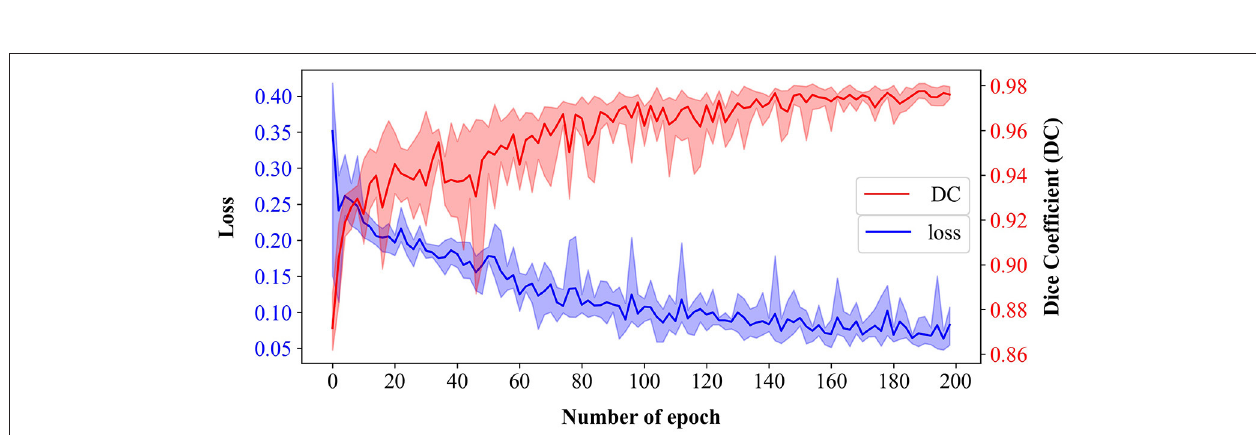
FIGURE 6 | Training loss and validation dice coefficient (DC) of U-Net-based model over 200 epochs from five-fold cross-validation. Bold lines represent the mean of loss (blue) and DC (red), and the translucent bands represent the range of loss and DC across five-fold.